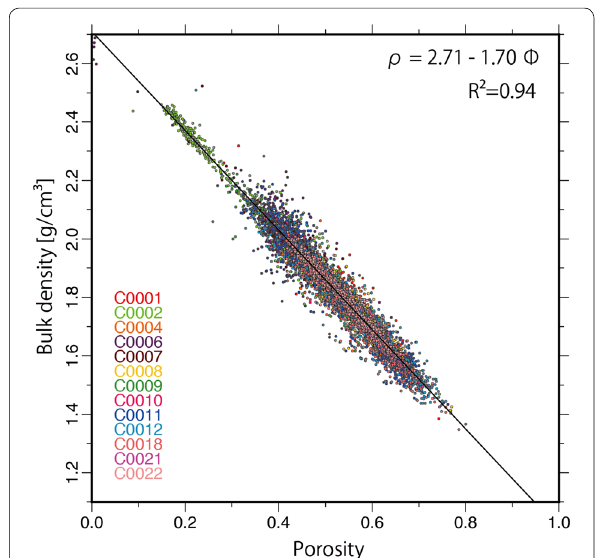
Fig. 4 Correlation between bulk density and porosity